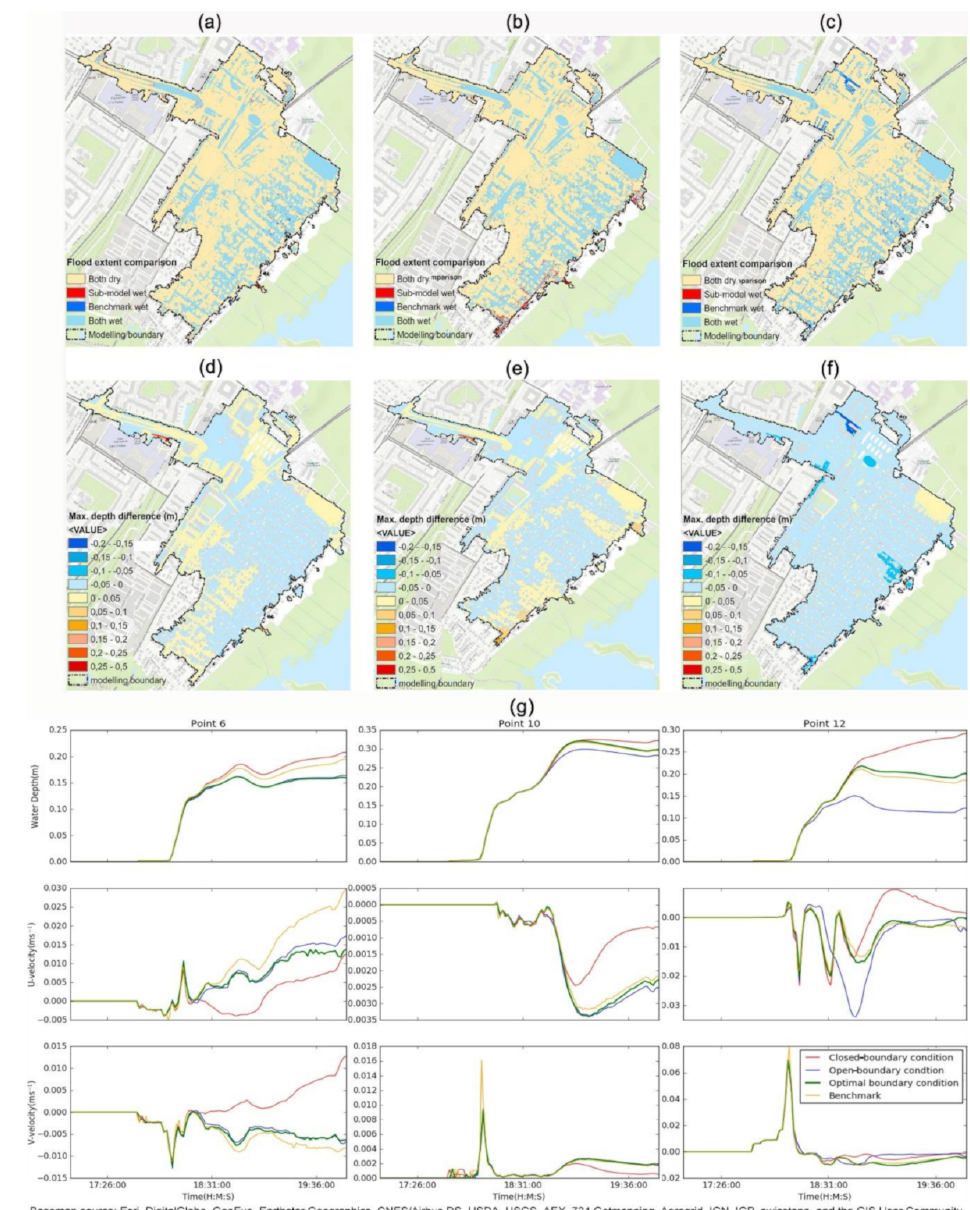
Figure 11. Benchmarking discrepancies using different boundary condition strategies: ( a ) the opti- mised boundary condition’s flood extent categorised map, ( b ) the uniform closed-boundary condi- tion’s flood extent categorised map, ( c ) the uniform open-boundary condition’s flood depth difference map, ( d ) the optimised boundary condition’s flood depth difference map, ( e ) the uniform closed- boundary condition’s flood depth difference map, ( f ) the uniform open-boundary condition’s flood depth difference map; ( g ) flood depth, u- and v-velocity hydrographs for points 6, 10 and 12 using the different boundary